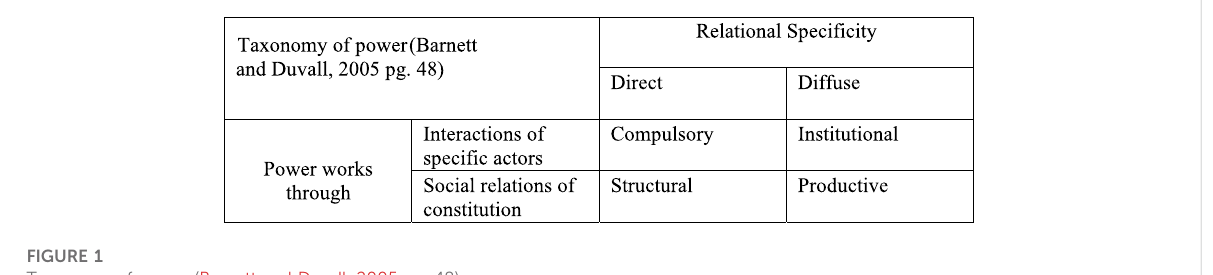
FIGURE 1 Taxonomy of power (Barnett and Duvall, 2005 pg.